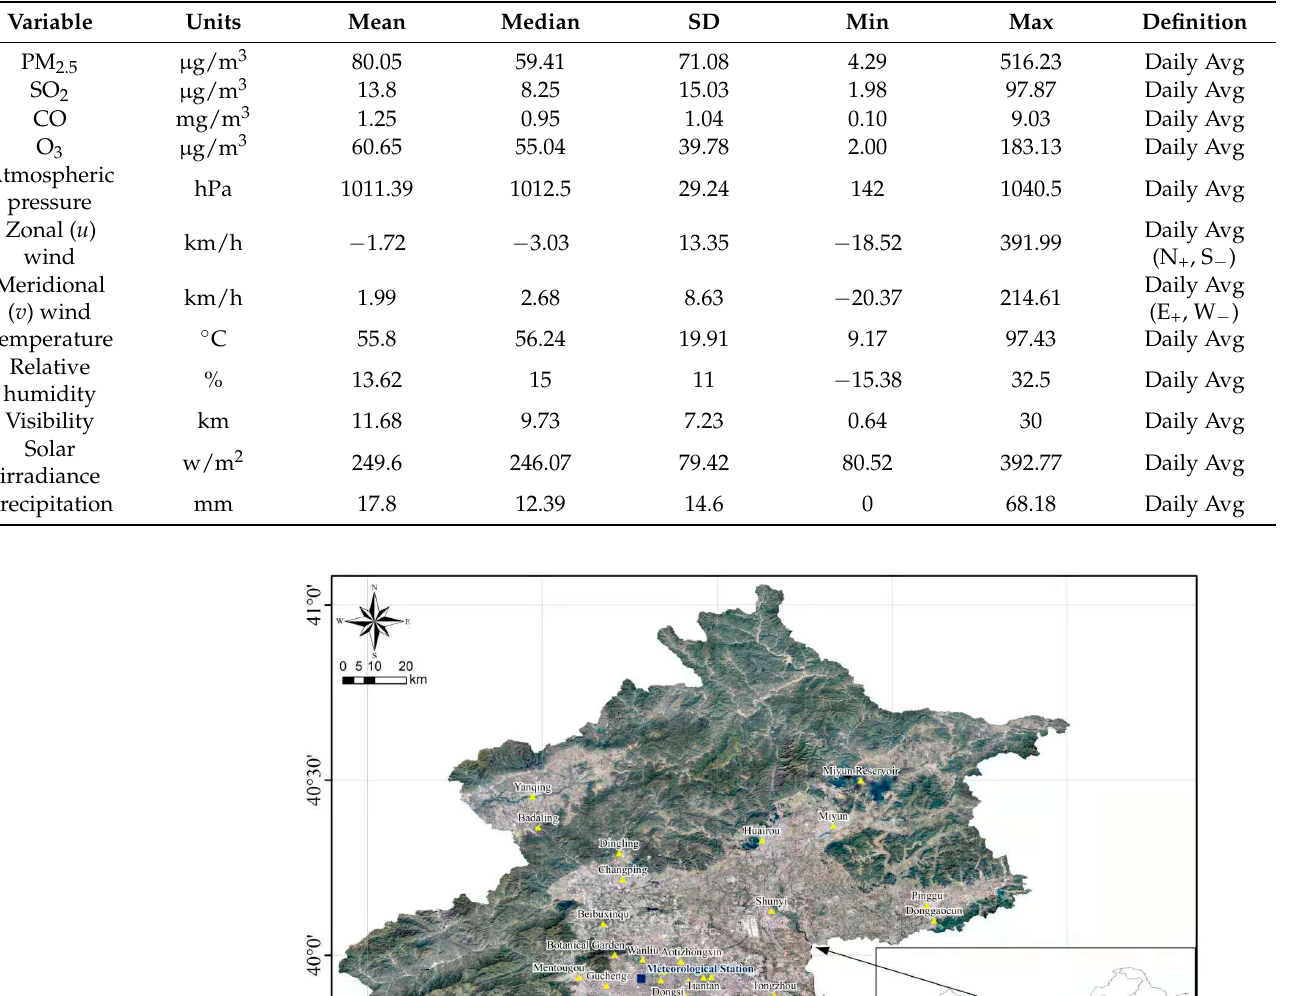
Table 1. Detailed characteristics of the data used in the model.